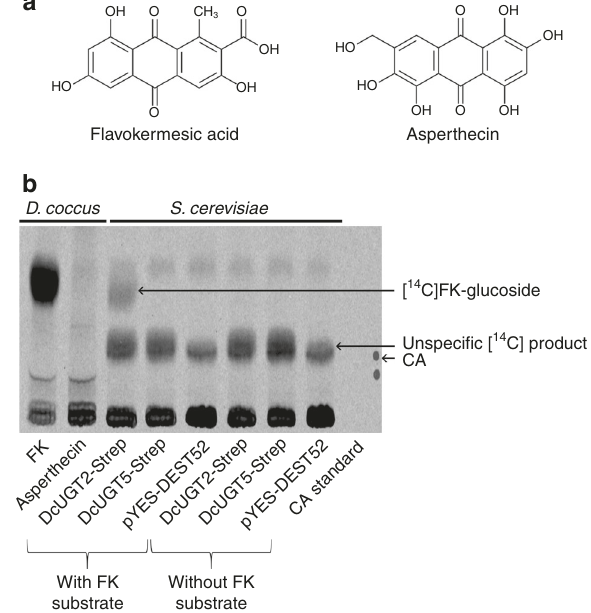
Fig. 4 Identi fi cation of a DcUGT glucosylating FK in vitro. Microsomes of D. coccus and of yeast expressing Strep-tagged DcUGT2 , DcUGT5 and p YES- DEST52 vector, respectively, were incubated with [ 14 C]UDP-glucose and with/without fl avokermesic acid. As a control, D. coccus microsomes were incubated with the asperthecin aglucone and [ 14 C]UDP-glucose. Formed products were separated by TLC. a Aglucone substrates tested in the